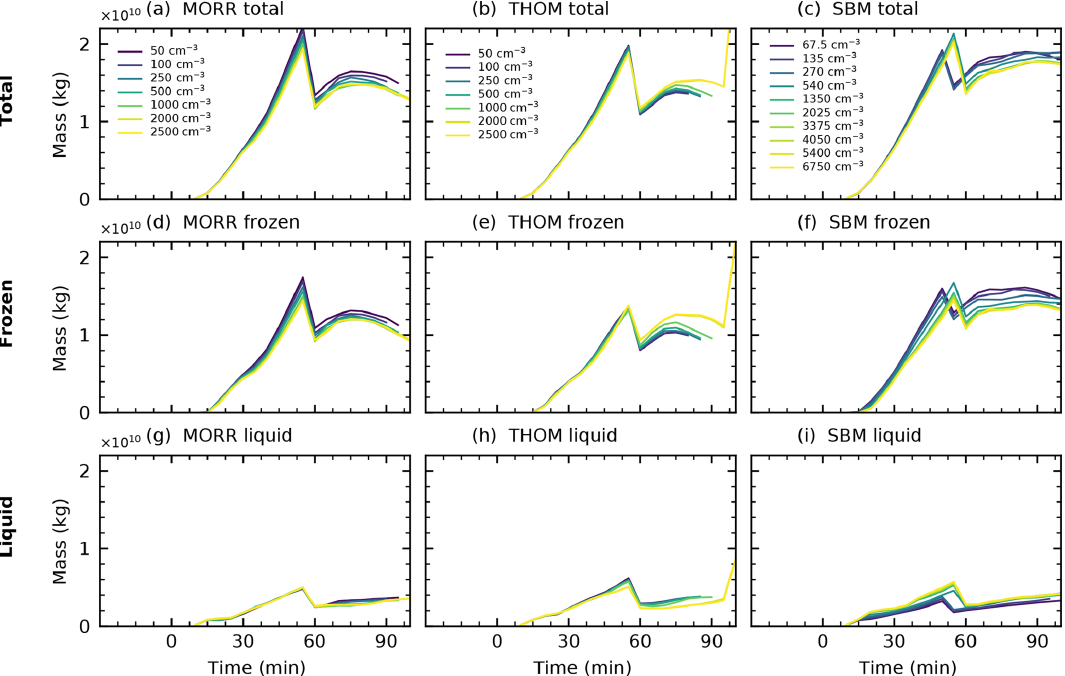
Figure 12. Total water mass, liquid water mass and frozen water mass in the analysed right-moving cell for the three different microphysics schemes (Morrison: a , d , g , Thompson: b , e , h , SBM: c , f , i ) in CASE1. The jump in the curves occurs at the point where the cell splits into two individual